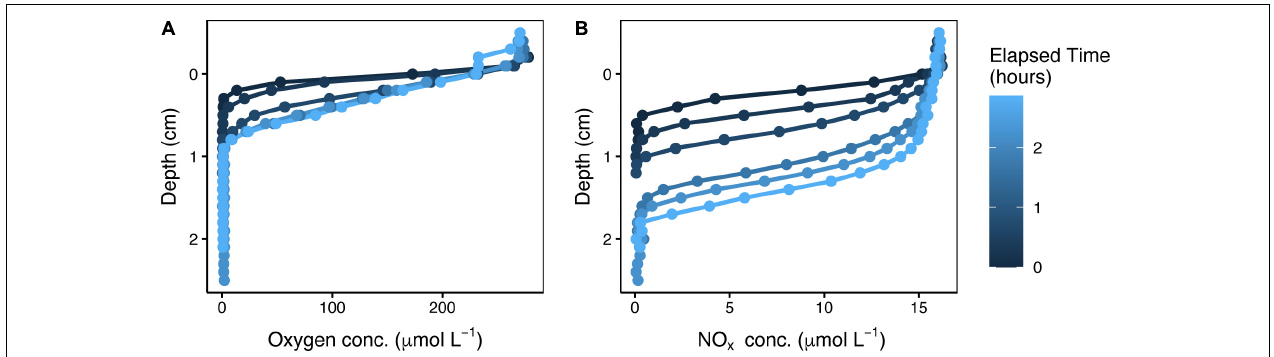
FIGURE 3 | Time series of oxygen (A) and NO x (B) depth profiles after onset of downward water flow through a sediment core. These representative profiles are from the spring, in the dark, with a low flow rate of 0.11 mL min − 1 .